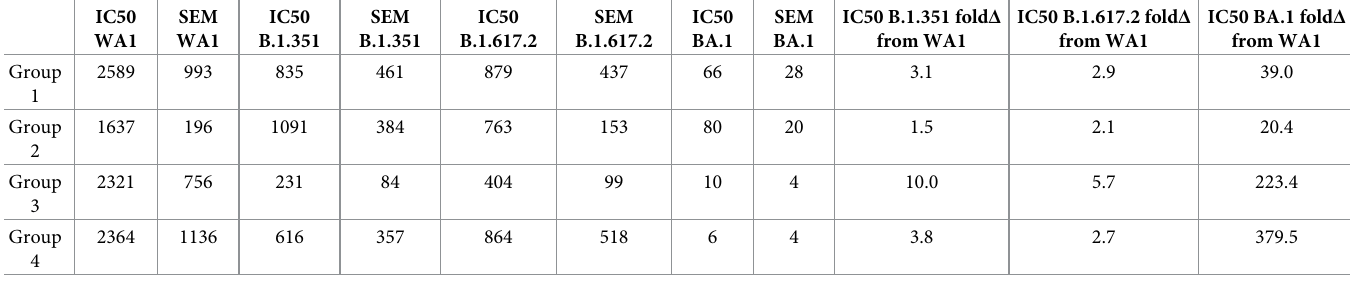
IC50s were derived from neutralization curves in Figs 4–6. IC50s were determined by nonlinear curve fit as described in Material and